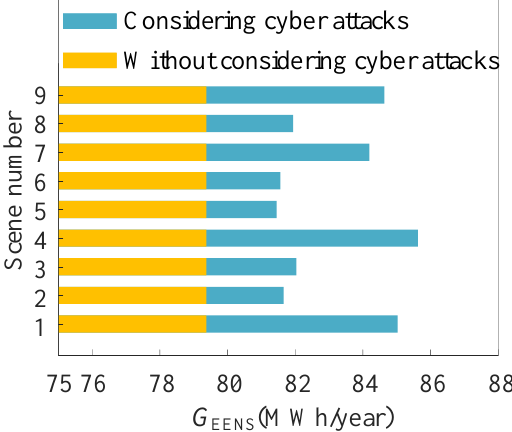
Figure 19. Impact of attacking two IEDs on G EENS .